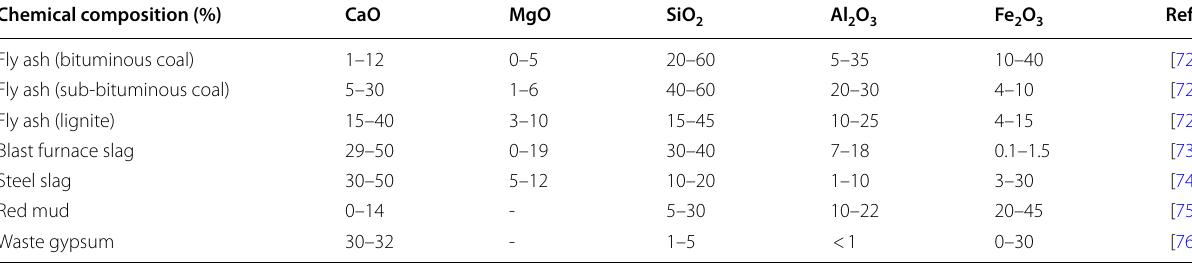
Table 1 Composition of the industrial wastes with potential in mineral carbonation Chemical composition